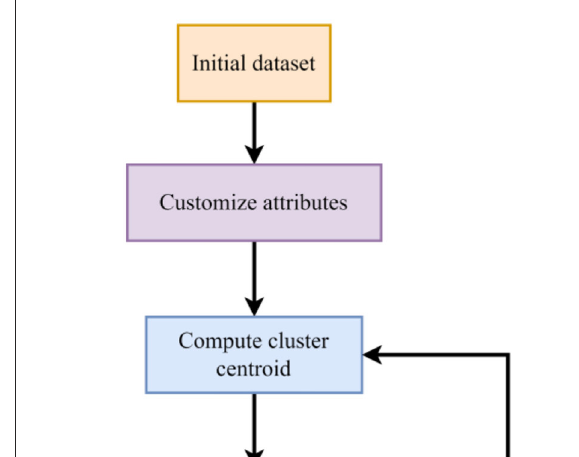
FIGURE5 Flowchart of fuzzy c-means algorithm.